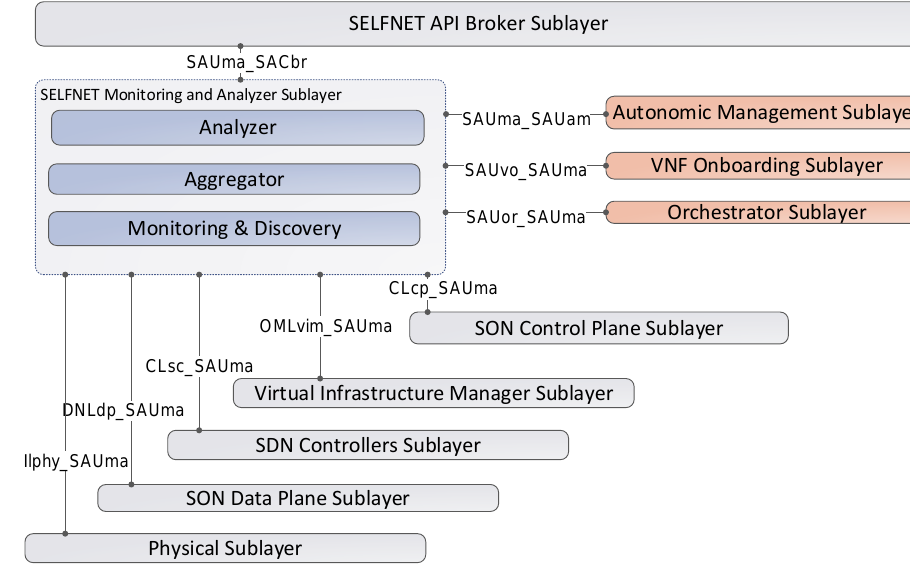
Figure 5. Monitor and Analyzer Sublayer Interfaces. Table 2. Monitor and Analyzer Interfaces.